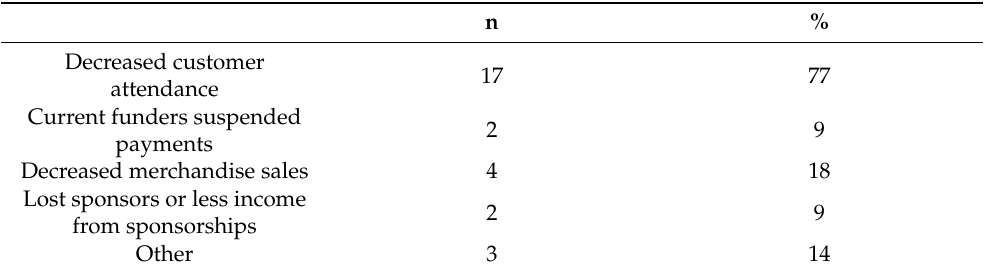
Table 7. Actions Leading to Lost Revenue During June, July, and August 2020 as Compared to 2019. n